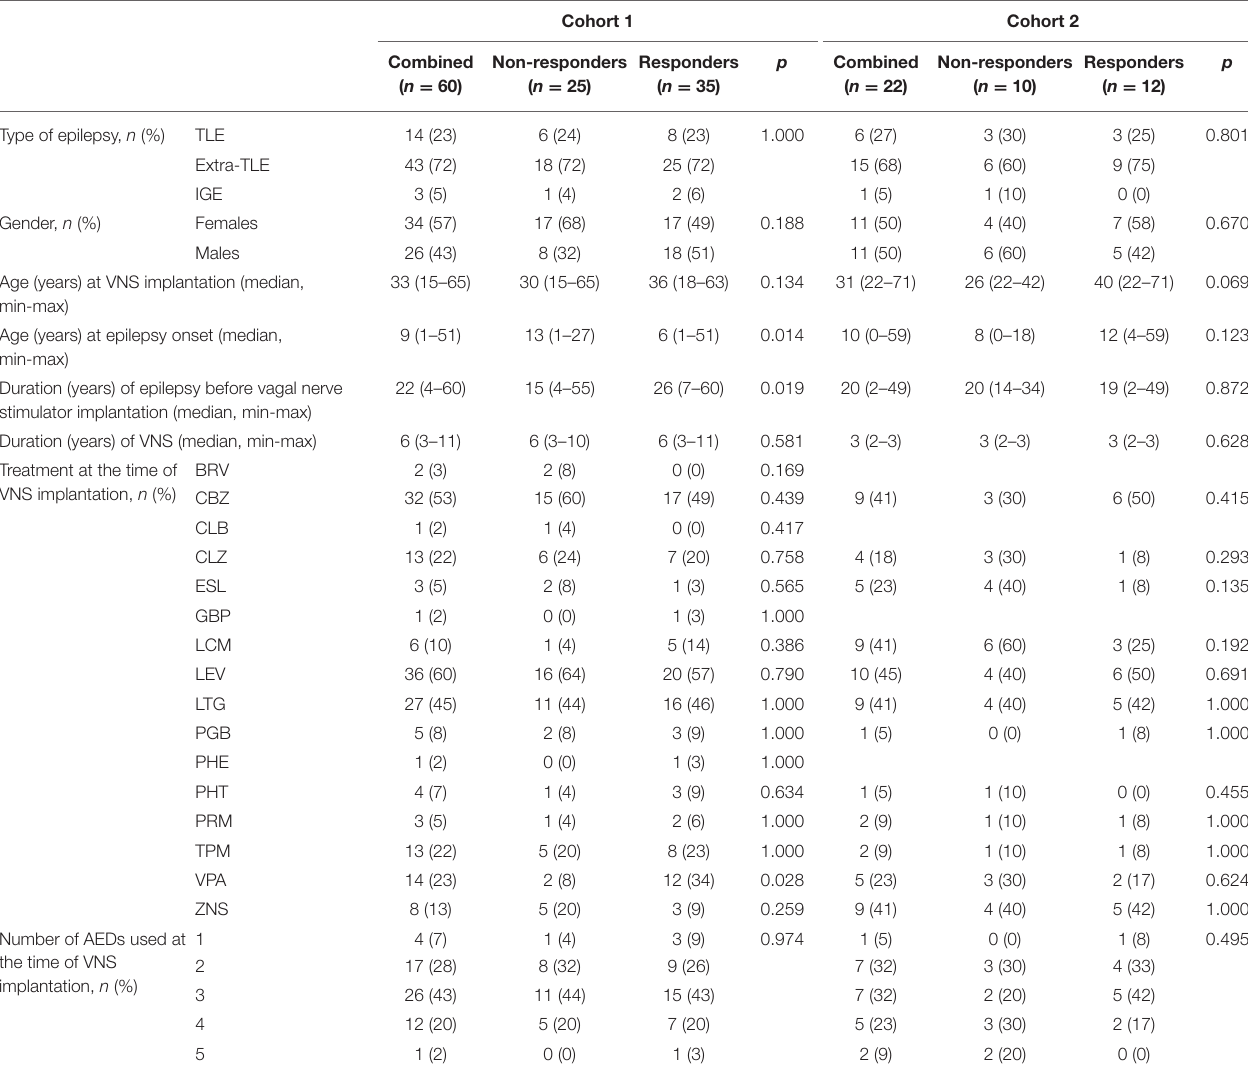
TABLE 1 | Demographic and treatment data for Cohort 1 and Cohort